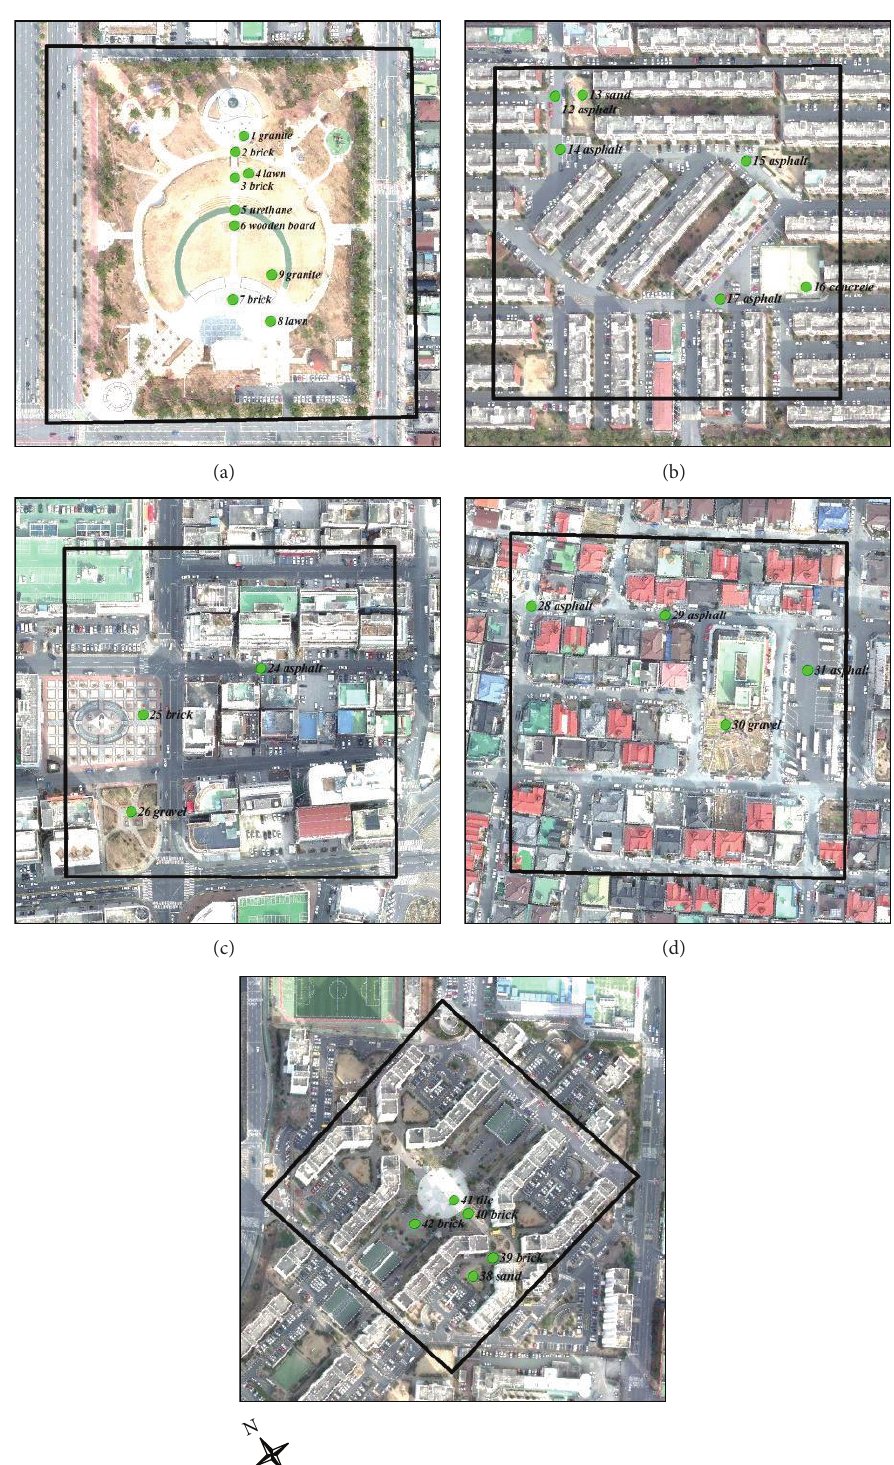
Figure 2: Field measurement points in the analysis target sites: (a) urban park area (9 points), (b) low-rise apartment area (6 points), (c) high-rise commercial area (3 points), (d) single residential area (4 points), and (e) high-rise apartment area (5